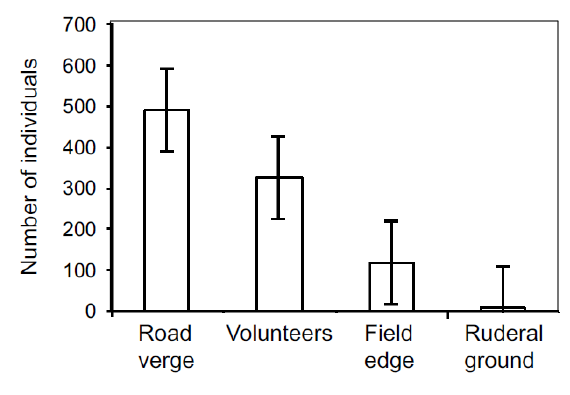
Figure 4. Mean number (±SD) of OSR individuals in different habitat categories. A description of each habitat category is given in the material and